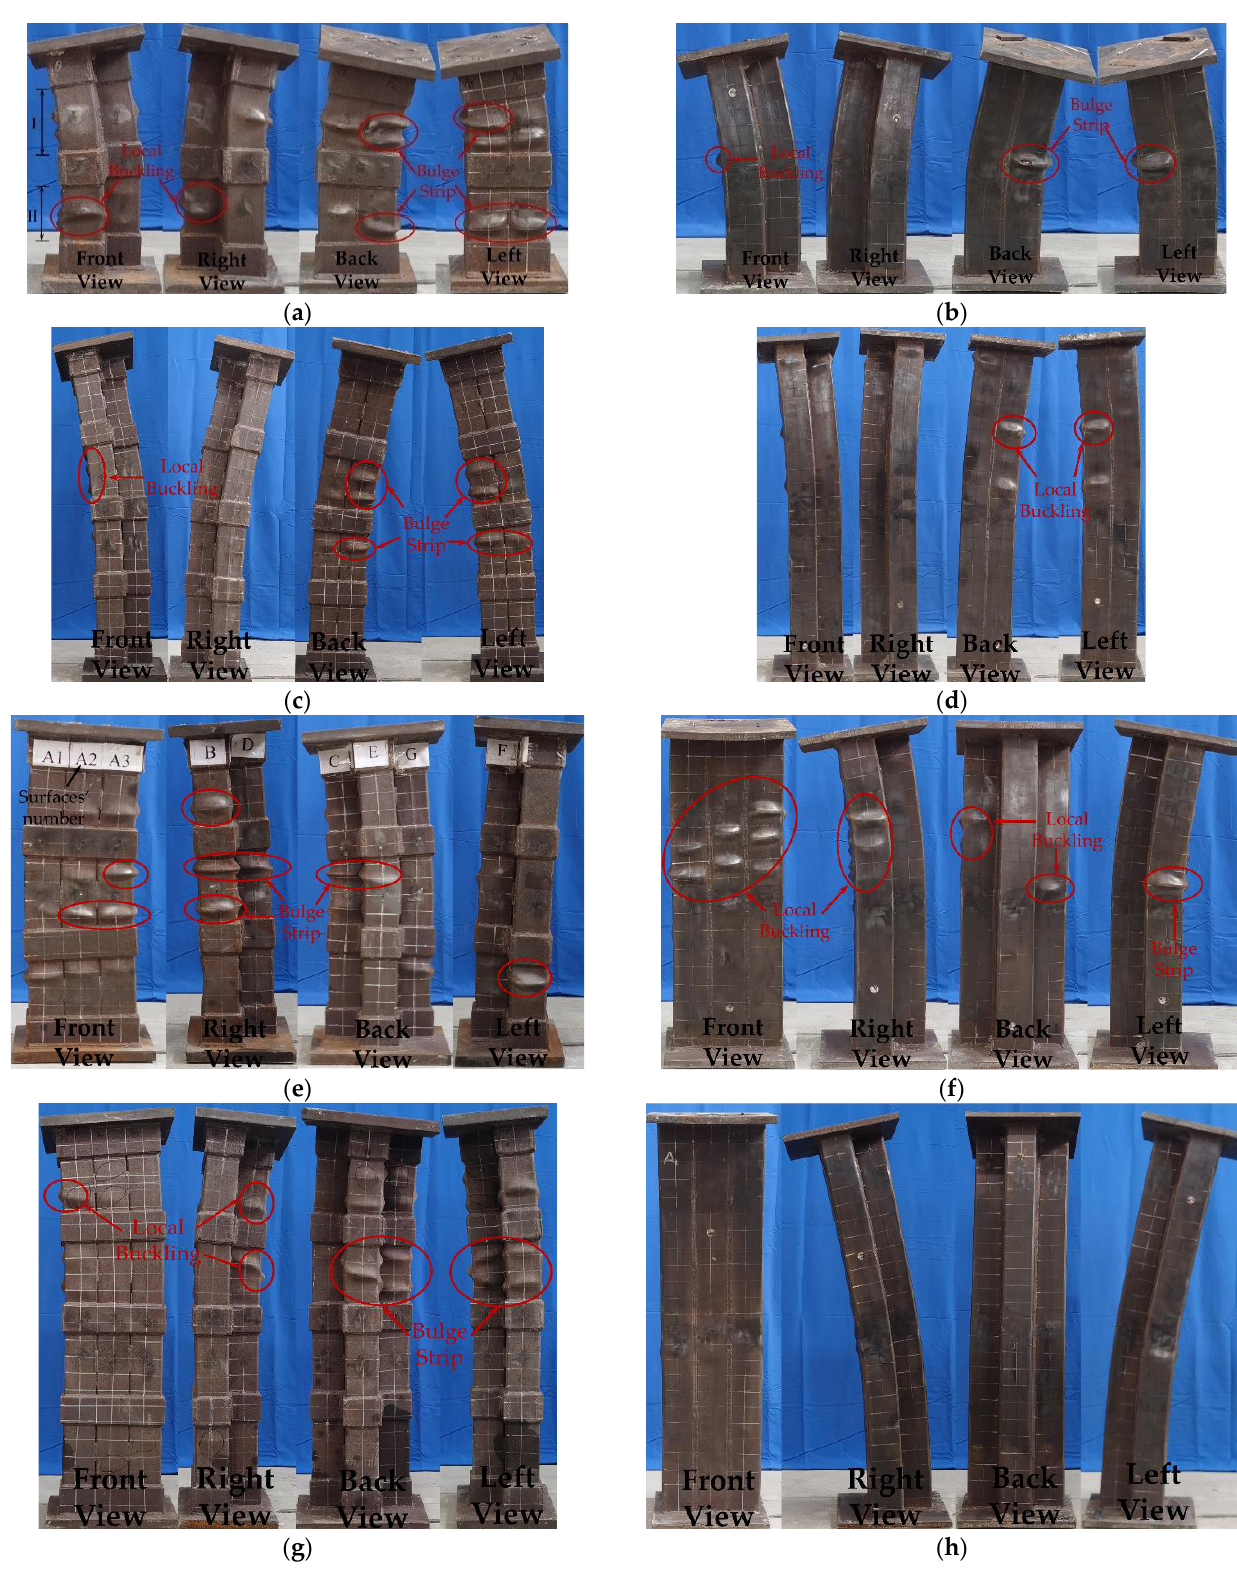
Figure 9. Failure modes of test specimens ( a ) HL-1; ( b ) WL-1; ( c ) HL-2; ( d ) WL-2; ( e ) HT-1; ( f ) WT-1; ( g ) HT-2; ( h ) WT-2.